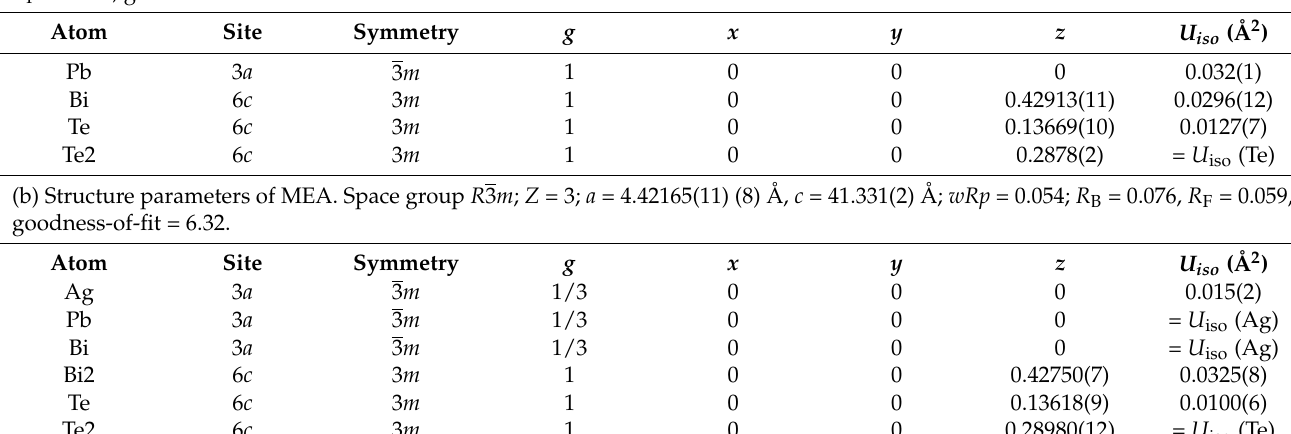
Table 2. Refinement results for the SXRD data. In analysis, the occupancy of 3 a site atoms were fixed nominal values,